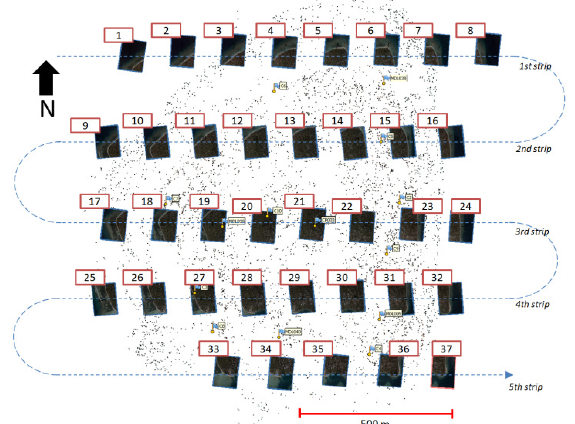
Figure 2. Configuration of the 37 images used in the project, including image numbers, flight direction, and the distribution of GCPs and check points over Gili